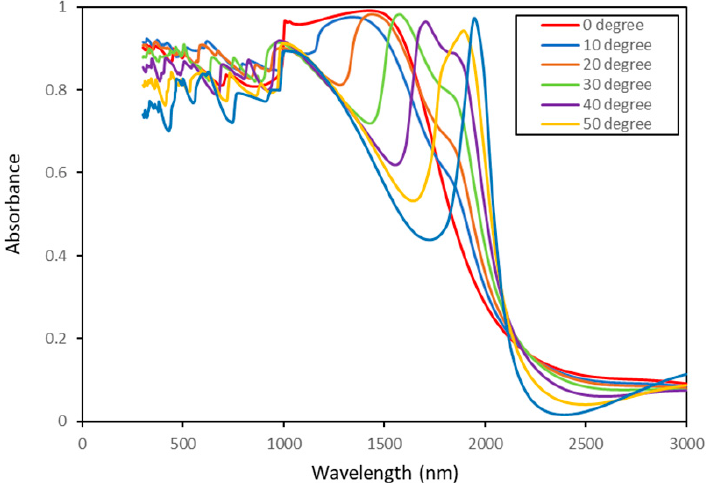
Figure 10. Absorbance spectrum regarding different incidence angles for an isotropic random rough surface.